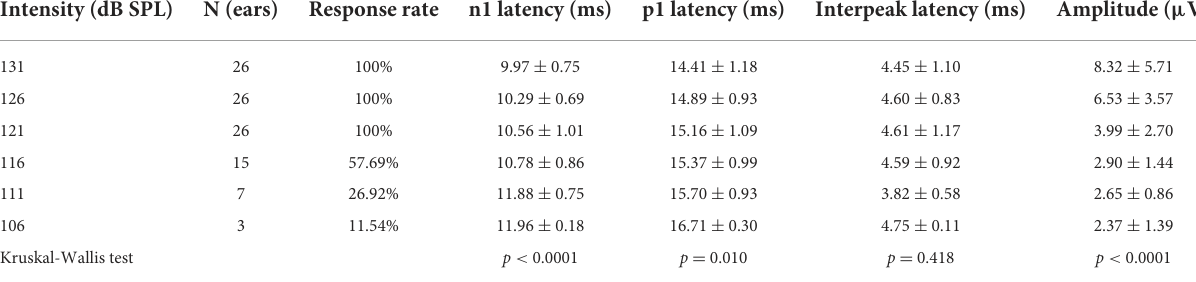
TABLE 1 The ACS-oVEMP with decreasing acoustic stimulation intensity in children.